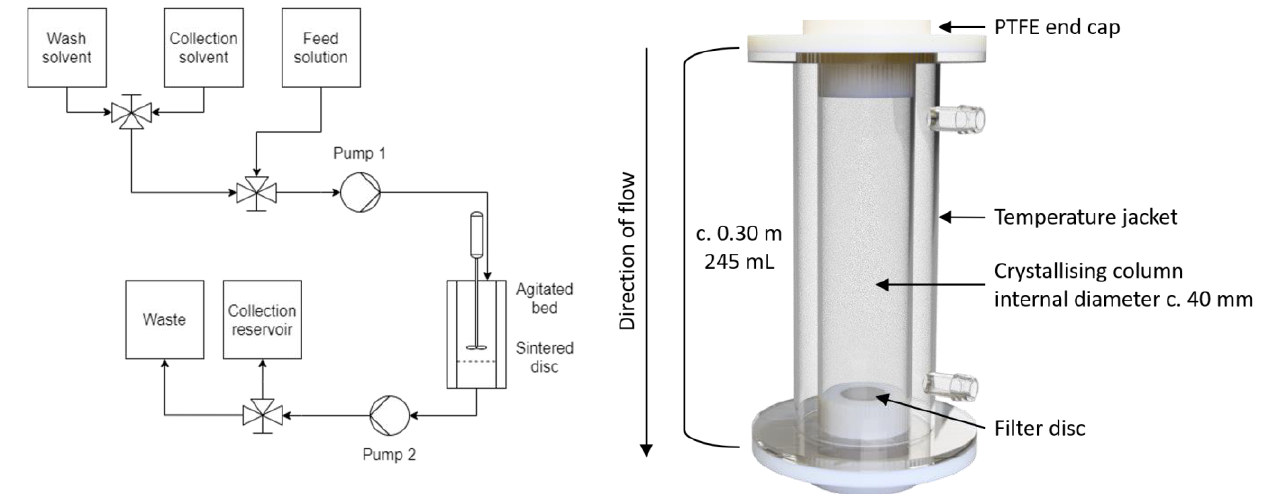
Figure 3. Diagrams of the agitated bed crystallizer. ( Left ) Process flow diagram of the agitated bed crystallizer, ( Right ) Design of the Confined suspension – agitated bed crystallizer.